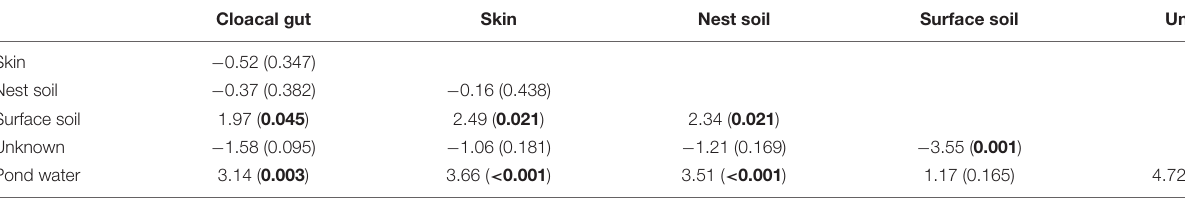
TABLE 1 | Pairwise comparison of the contribution ratios of all predicted sources by SourceTracker (P-values are in parentheses). Cloacal gut Skin Nest soil Surface soil